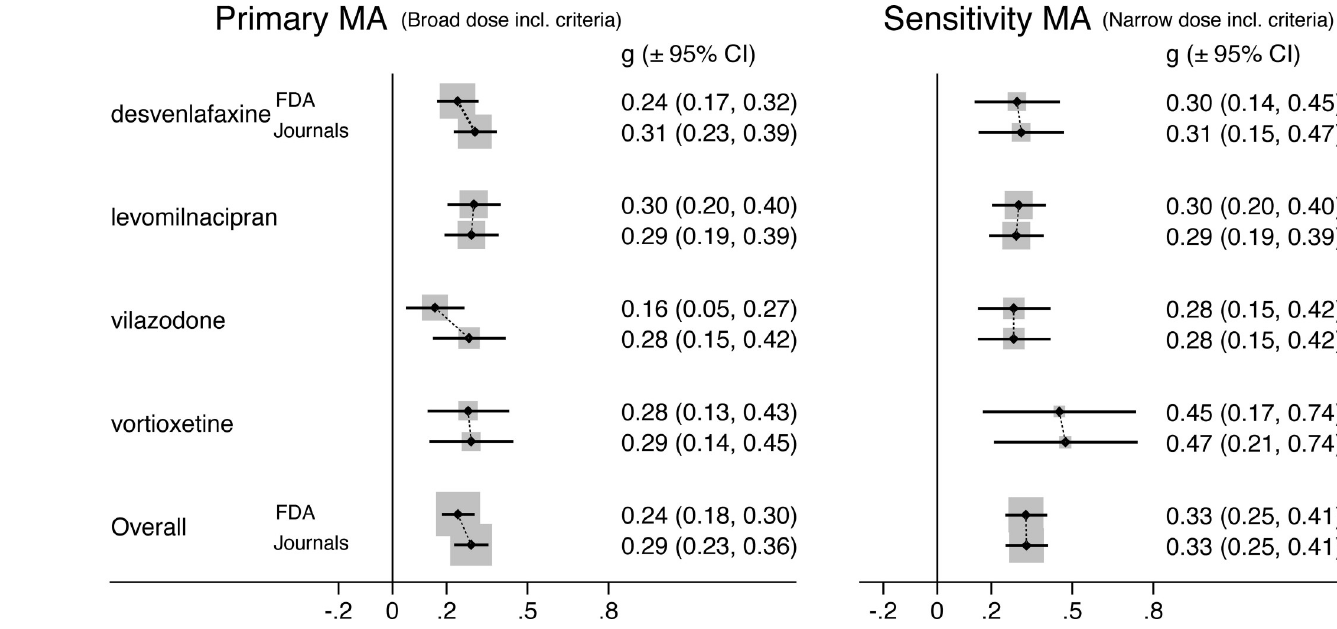
Fig 3. Meta-analytic ES of 4 newer antidepressants derived from trial reports in FDA reviews vs. journal articles. The primary (left panel) and sensitivity (right panel) MAs were based on broad and narrow/restrictive dose inclusion criteria, respectively, as described in text. For each antidepressant, 2 drug-level ES values are shown, one based on clinical trial data from FDA reviews and one based on data from the journal articles. ES, effect size; g, Hedges’s g; FDA, Food and Drug Administration; MA, meta-analysis.